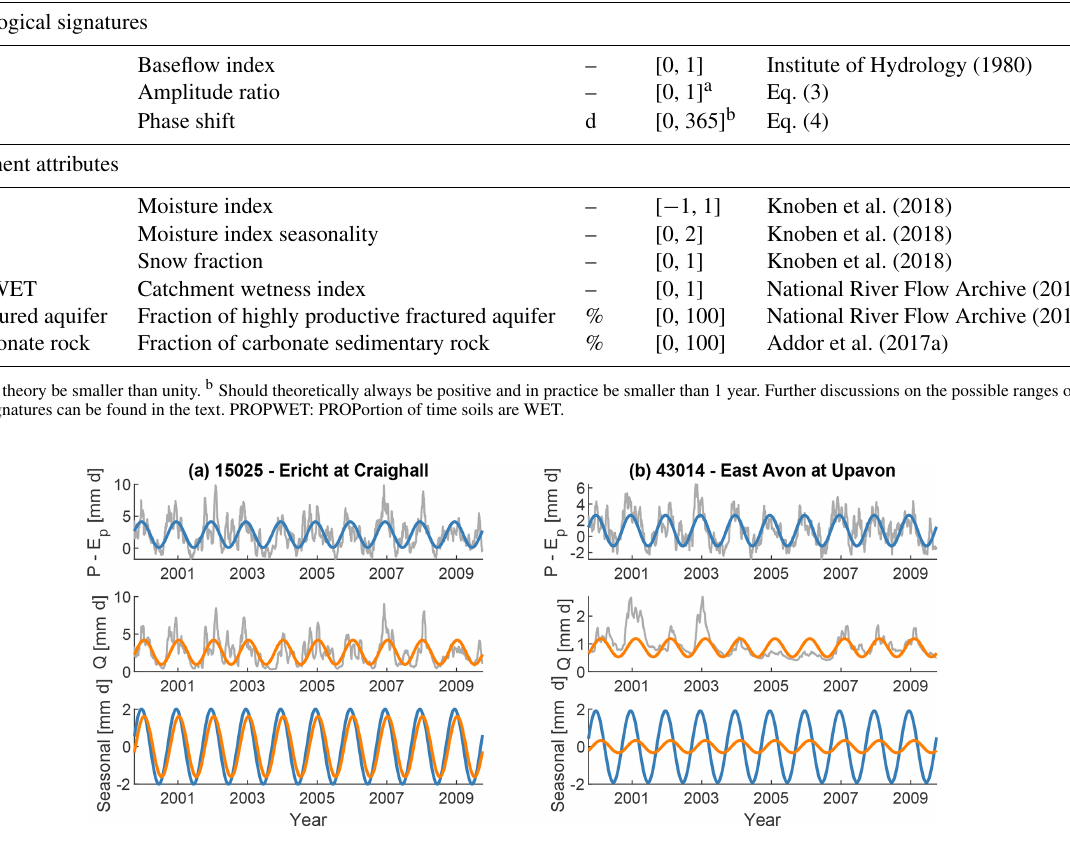
Figure 4. Climate input ( P − E p ; blue) and catchment output ( Q ; orange) for two example catchments in the UK and their respective seasonal components. The time series are smoothed using a 30d moving mean. The Ericht is a rather responsive catchment (BFI = 0.47), while the East Avon has a large baseflow component (BFI = 0.89). Note that for the bottom plots (“Seasonal”) the mean values of the sine curves are set to